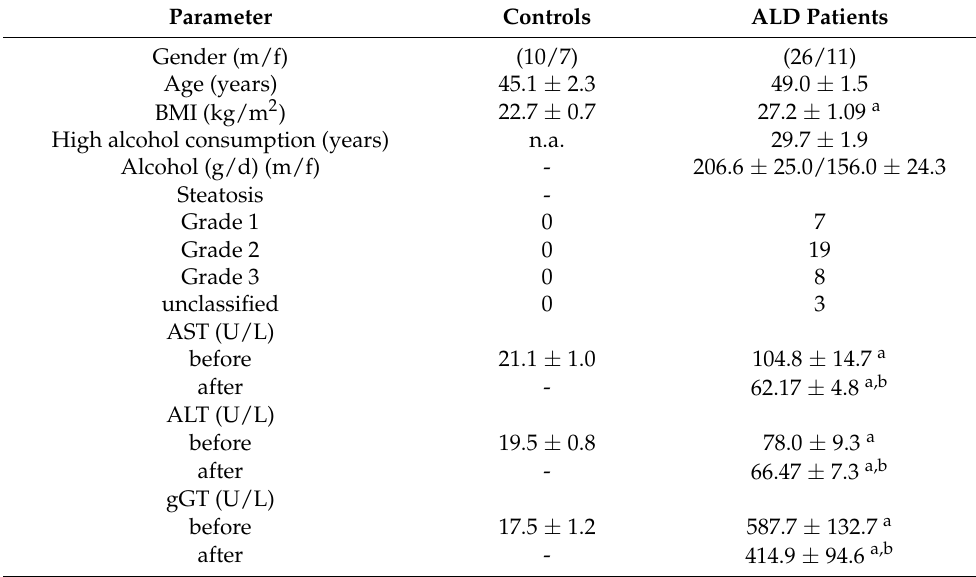
Table 1. Characteristics and liver parameters of healthy non-drinkers (controls) and patients with alcohol-related liver disease (ALD) undergoing alcohol